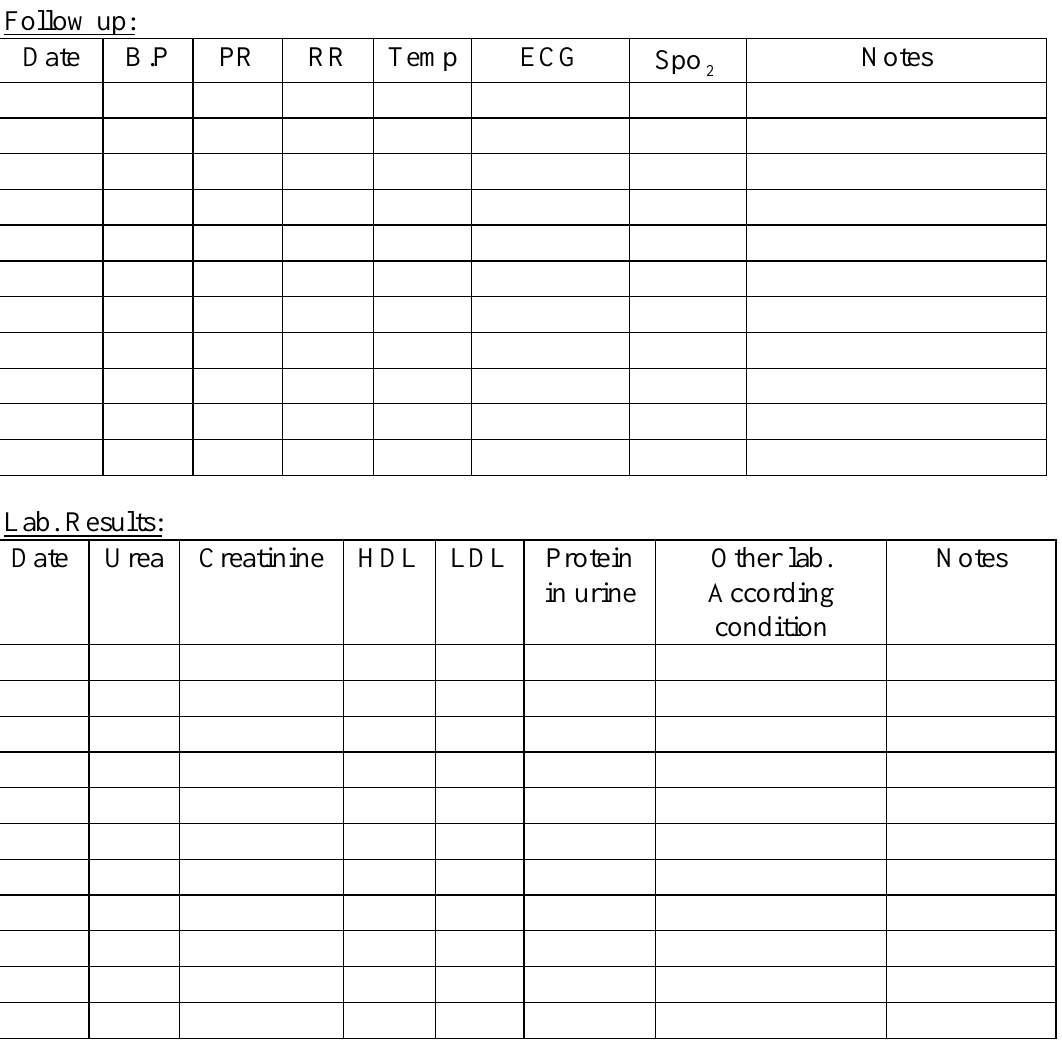
Figure (I): Case sheet of full information obtained from each